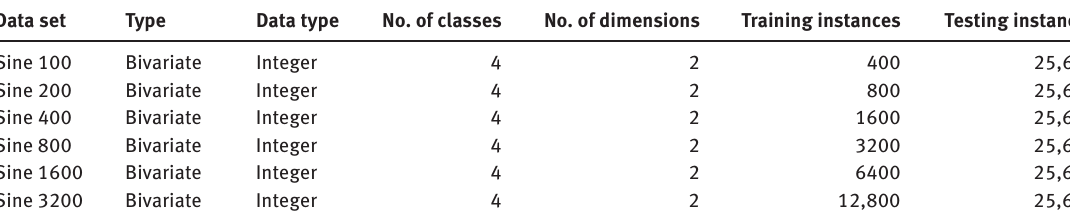
Table 1: Characteristics of the Non-overlapping Four-Class Synthetic Data Sets.